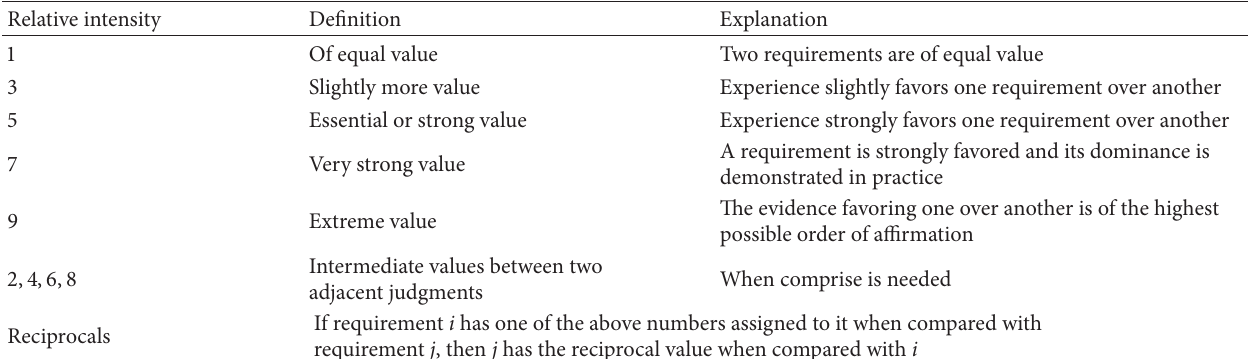
Table 7: Possible scales used for AHP’s pairwise comparison [1].